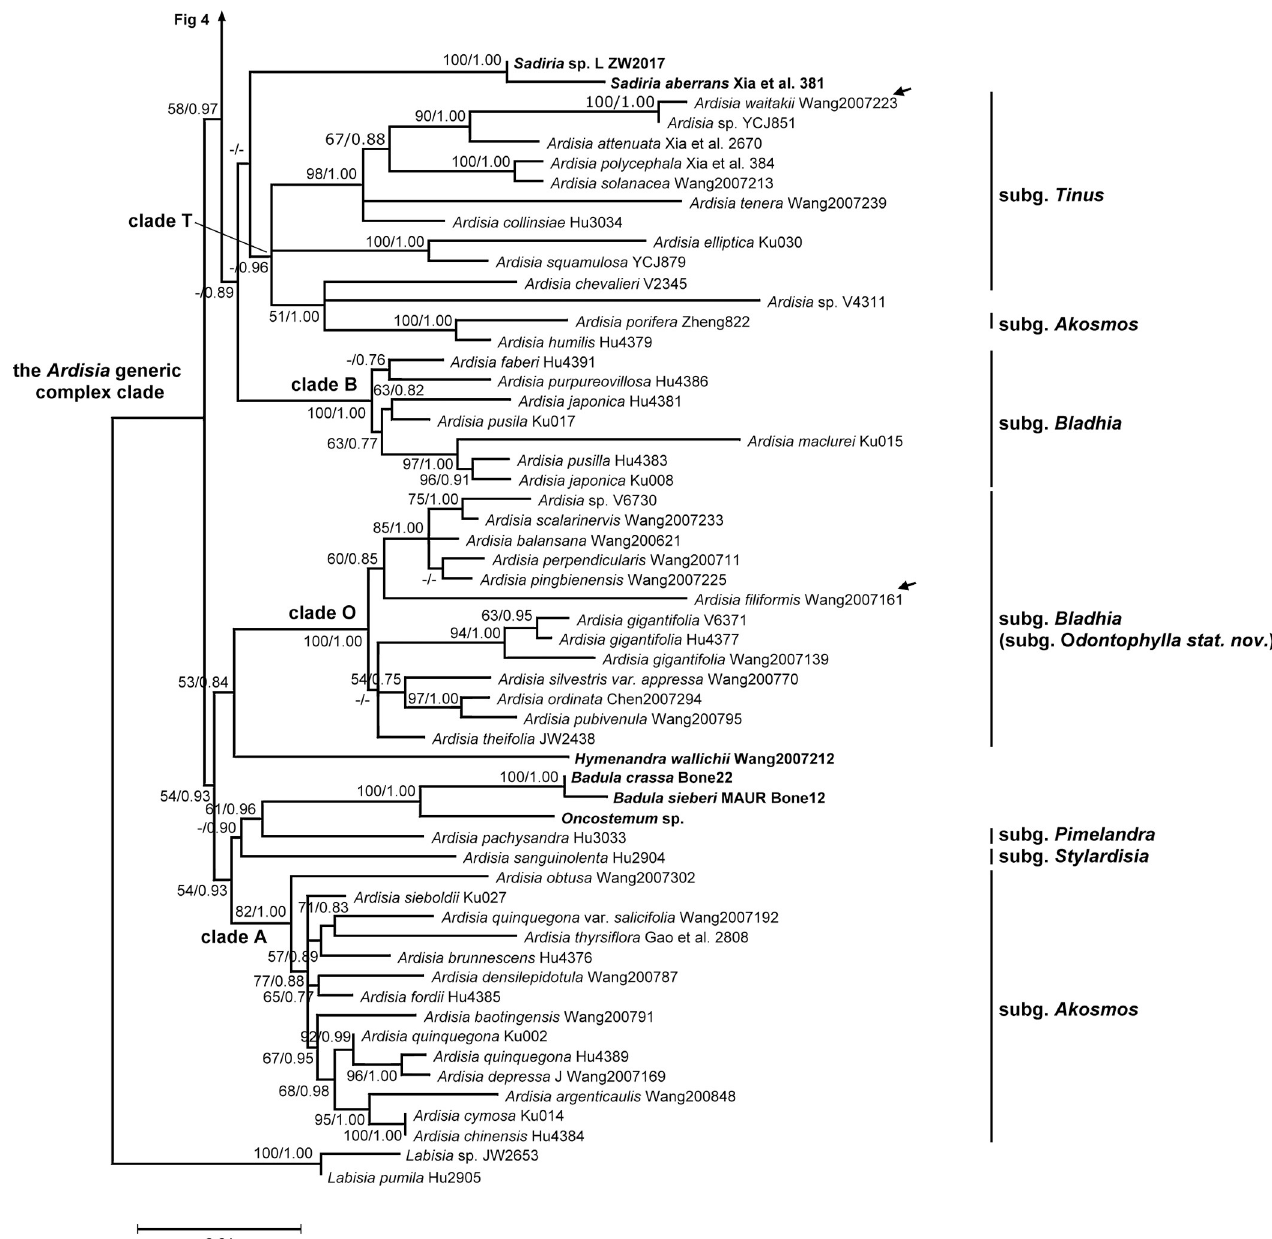
Fig 3. Phylogeny of Ardisia and allies inferred using maximum likelihood (ML) based on the combined dataset. Lower half of the tree. Combined dataset including nuclear ITS and two plastid intergenic spacer ( psbA-trnH and rpl32-trnL ) sequences. Numbers at branches are ML bootstrap support values and Bayesian posterior probabilities. ML bootstrap support values are indicated only if at least 50, and the Bayesian posterior probabilities are indicated only if at least 0.7. Alternative branching between the two different analyses was showed as no support at the branch. Non- Ardisia species nested within the Ardisia generic complex are shown in boldface. Arrows indicate the presumed misidentification. Collection numbers are labeled after species